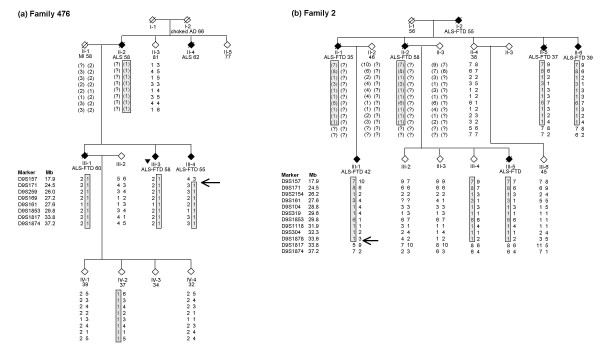
Pedigrees showing affection status, individual IDs, and haplotypes for (a) family 476 and (b) family 2. Gender has been masked to protect the anonymity of the families. Probands are indicated by arrows; open symbol, unaffected; shaded symbol, affected; diagonal line, deceased; current age, or age at death and cause of death, is indicated. AD, Alzheimer Disease. Brackets around an allele indicate an inferred haplotype. Arrows show the limits of the haplotype.